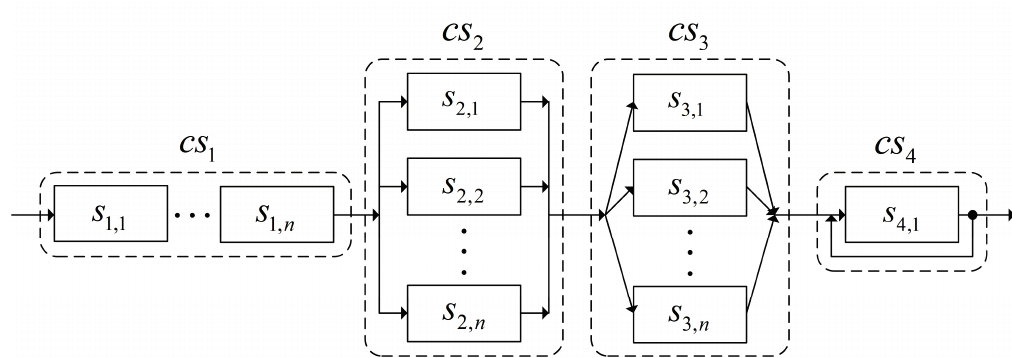
Figure 5. Composite structure of an example of SCA